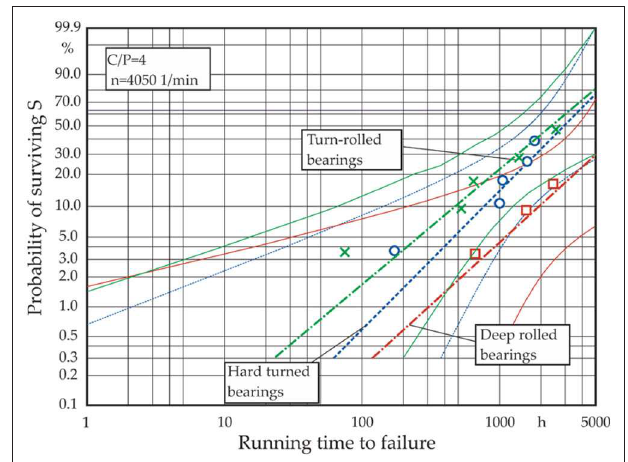
FIGURE 5 | Weibull plot for inner ring failure of CRB NU206 in dependence of the manufacturing strategy.